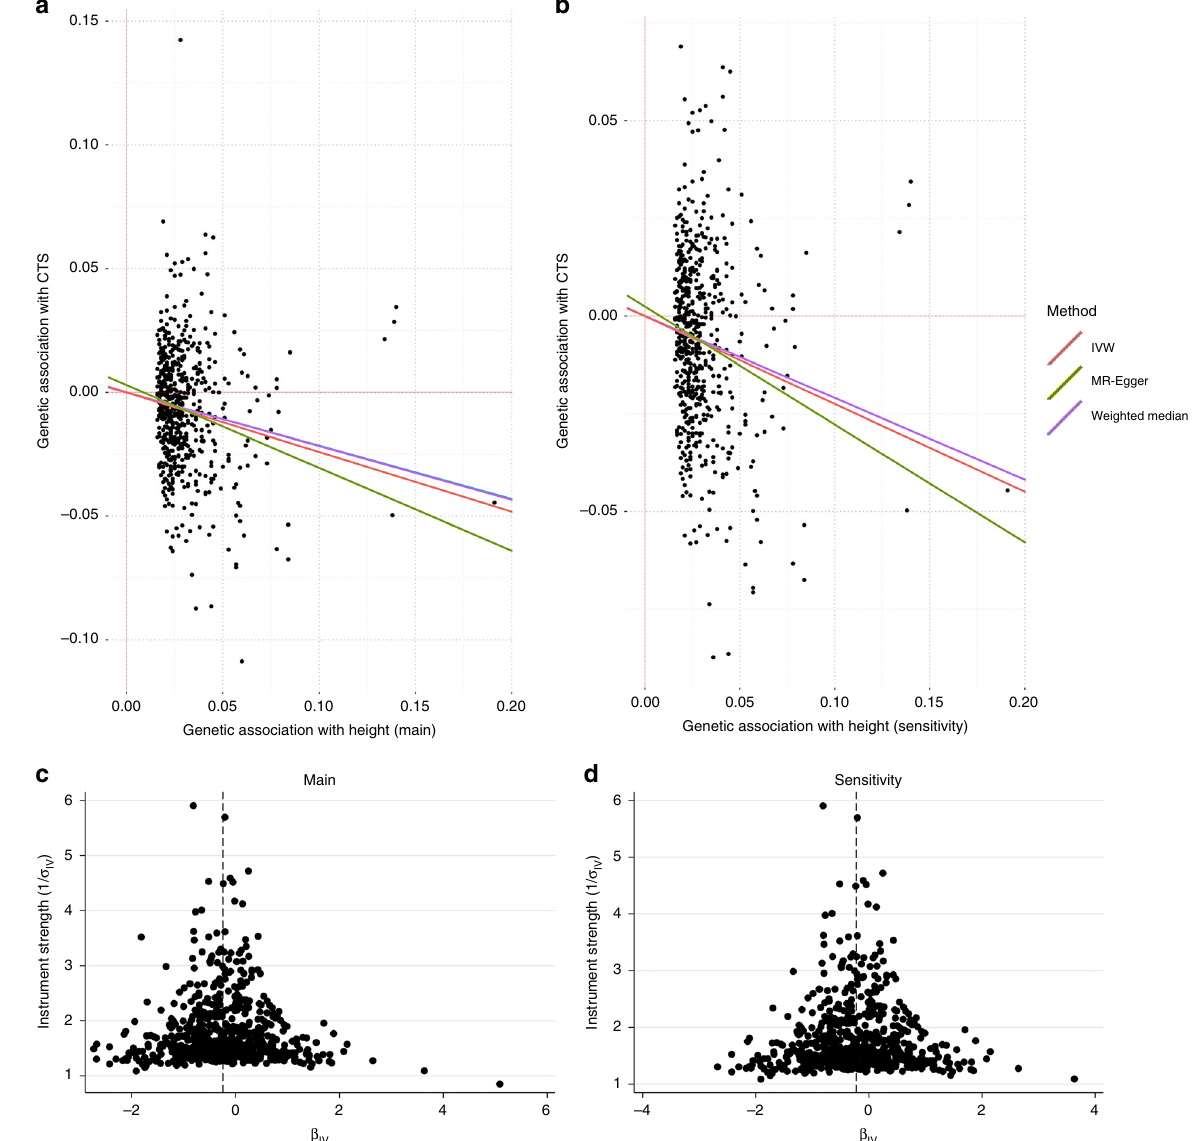
Fig. 3 Mendelian randomisation (MR) analysis of height and CTS. a MR plots for the main analysis (601 SNPs) using IVW, MR-Egger and weighted median methods. b MR plots for the sensitivity analysis (596 SNPs), with 5 SNPs that were signi fi cantly associated with both height and CTS removed. c Funnel plot of instrument strength vs effect size for the main analysis and d the sensitivity analysis. The removal of rs724016 (which is the only SNP with a 1/SE value of ~6 in plots ( c , d )) had no material effect on the MR estimates using IVW. Odds ratio for CTS per 1-SD higher height in the main analysis was 0.79 nucleotide polymorphism